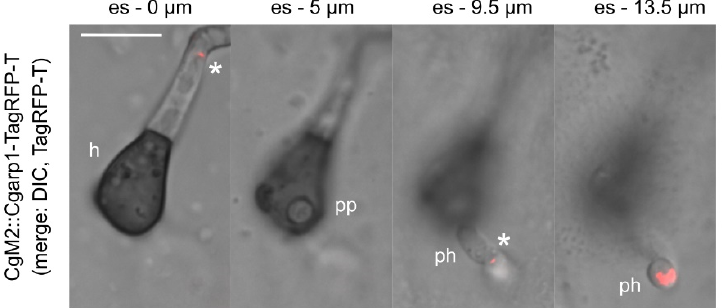
Figure 6. The visualization of penetration hyphae dynamics during onion epidermis perforation: 10 3 oval conidia of C. graminicola CgM2::Cgarp1-TagRFP-T were inoculated on a heat-inactivated onion epidermis overlaying water agar for 29 h at 23 °C. Different layers were recorded at a fixed distance of 0.5 µm originating from the epidermal surface (es). In the selected images of Video S7, size bar = 10 µm; h = hyphopodium; pp = penetration pore; ph = penetration hyphae; * non-tip localization of Arp1-TagRFP-T.